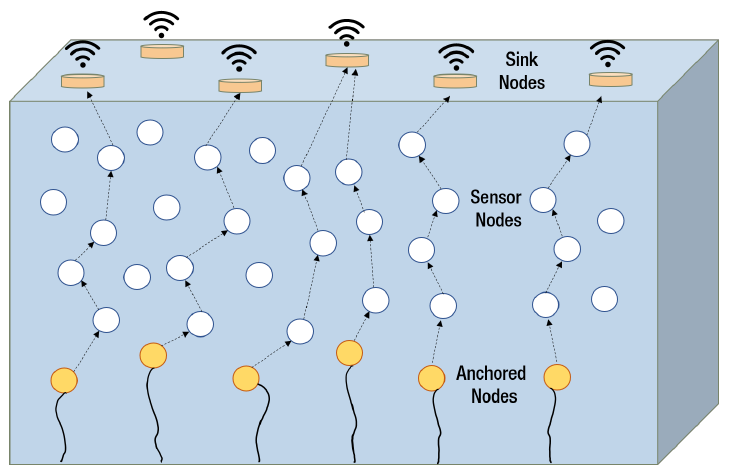
Figure 11. Network architecture of Energy Balanced Efficient and Reliable Routing Protocol (EBER 2 )